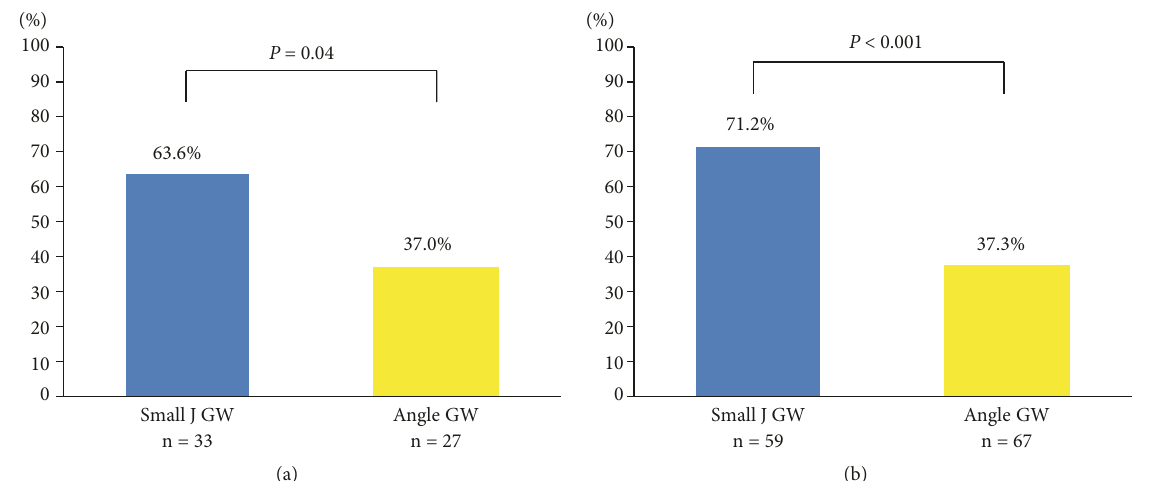
Figure 3: The rate of procedure completion by first guidewire. (a) Patients with chronic pancreatitis. (b) Patients with flexion angle of the pancreatic duct < 90 ∘ .